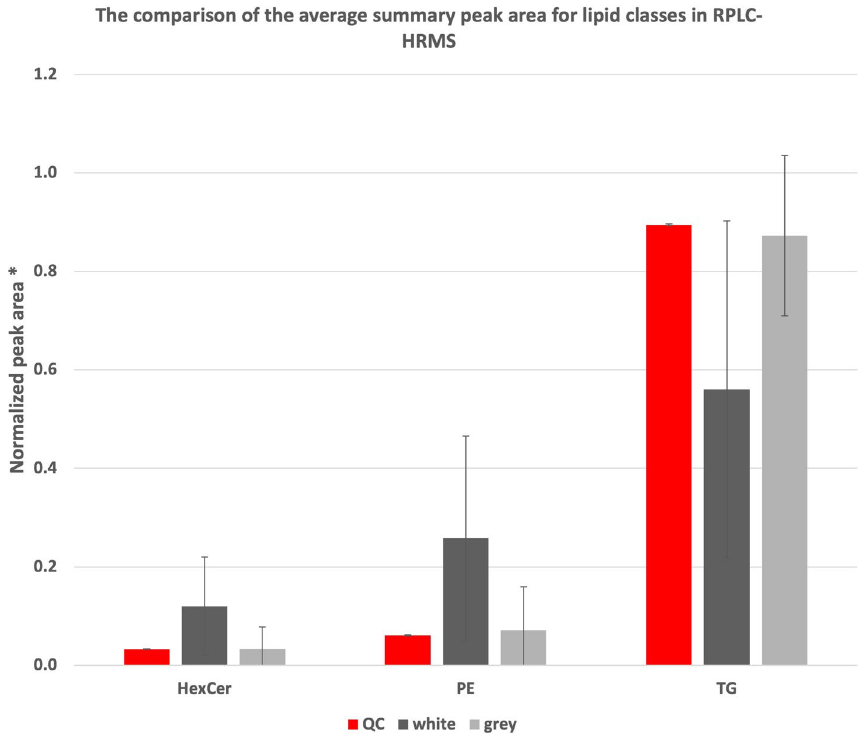
Figure 4. The comparison of the average summary peak area for lipid classes in RPLC-HRMS. Plots with mean normalized peak areas for lipid classes with with whiskers representing standard deviation. *Ratio of the peak area and total peak area for lipids. HexCer —Hexosyl ceramide, PE —Phosphatydyloetanoloamines, TG — Tryglicerides, QC —Quality